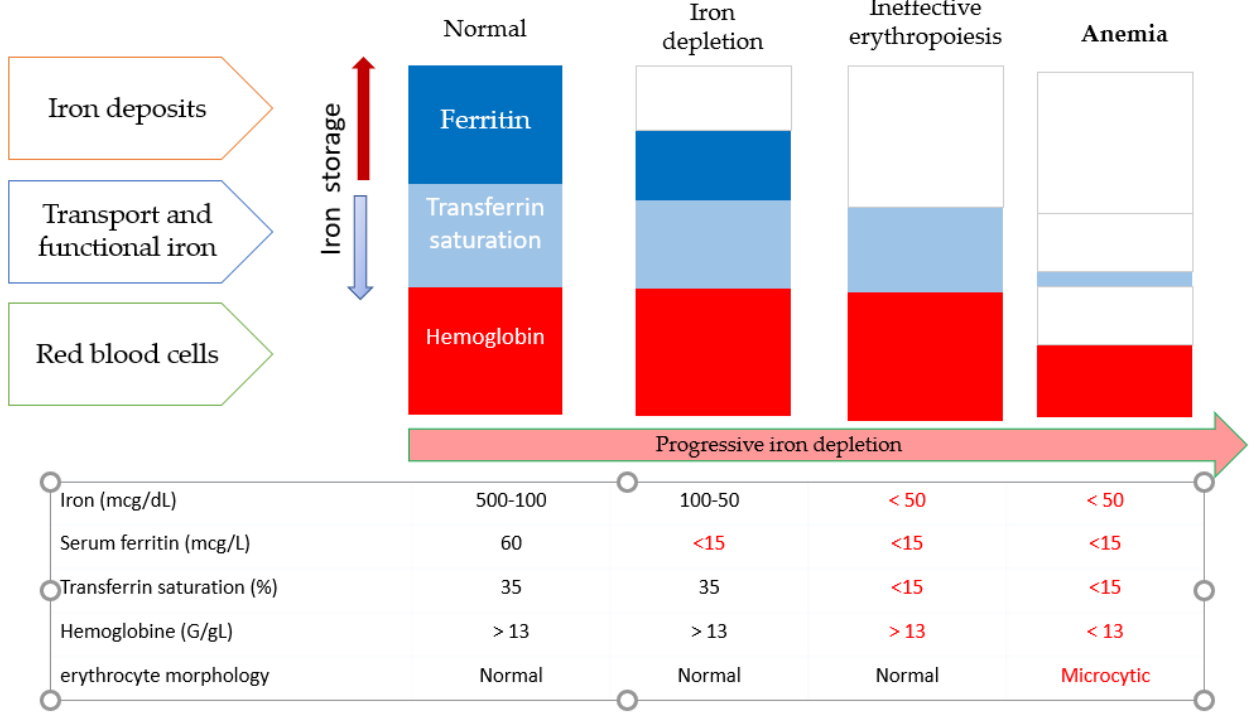
Figure 1. Diagnosis of iron deficiency.